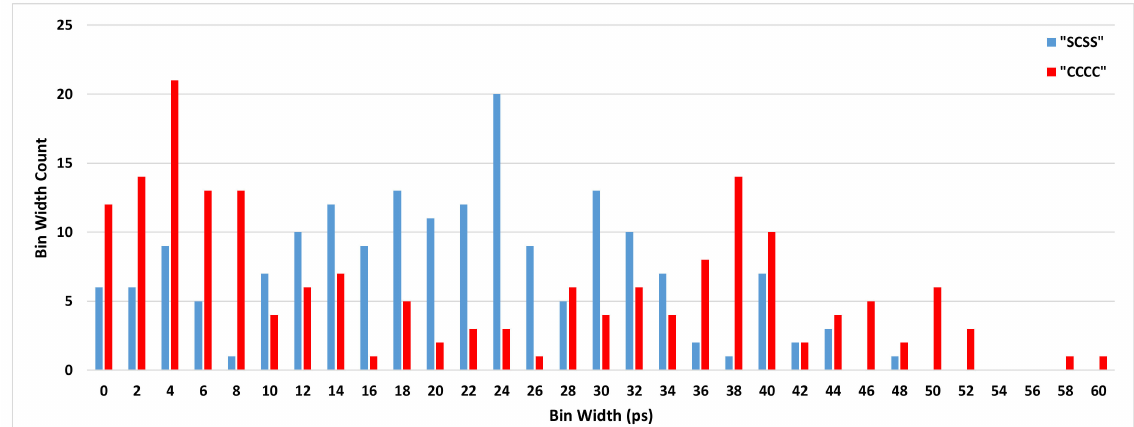
Figure 8. Bin width distributions of “SCSS” and “CCCC” sampling patterns.